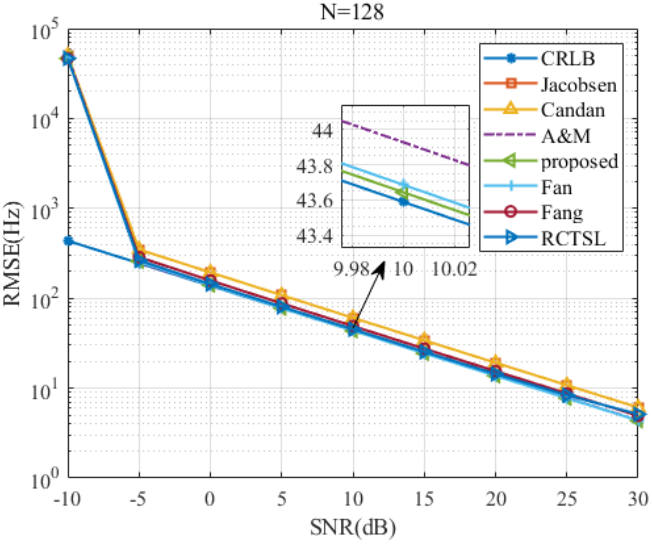
Figure 8. RMSE comparison among frequency estimates versus SNR at N = 128 and δ =